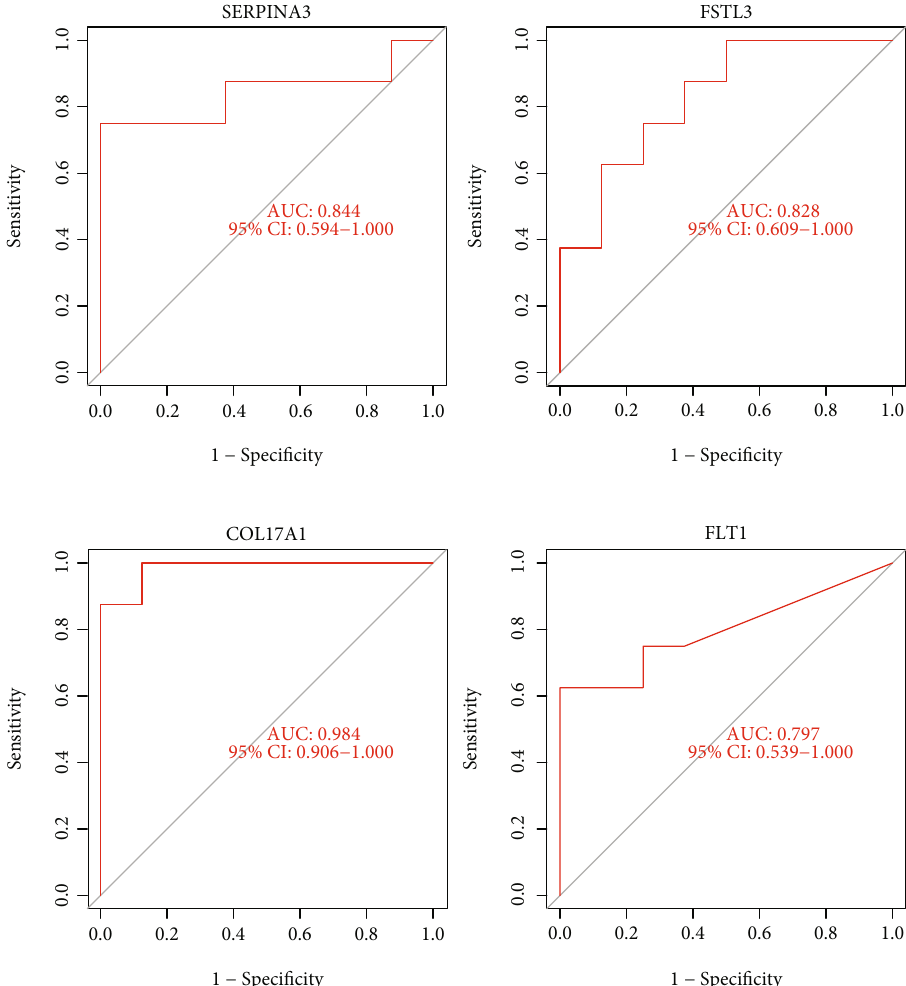
Figure 7: Among the 9 critical genes, four genes (COL17A1, FLT1, FSTL3, and SERPINA3) were further demonstrated to be diagnostic genes in